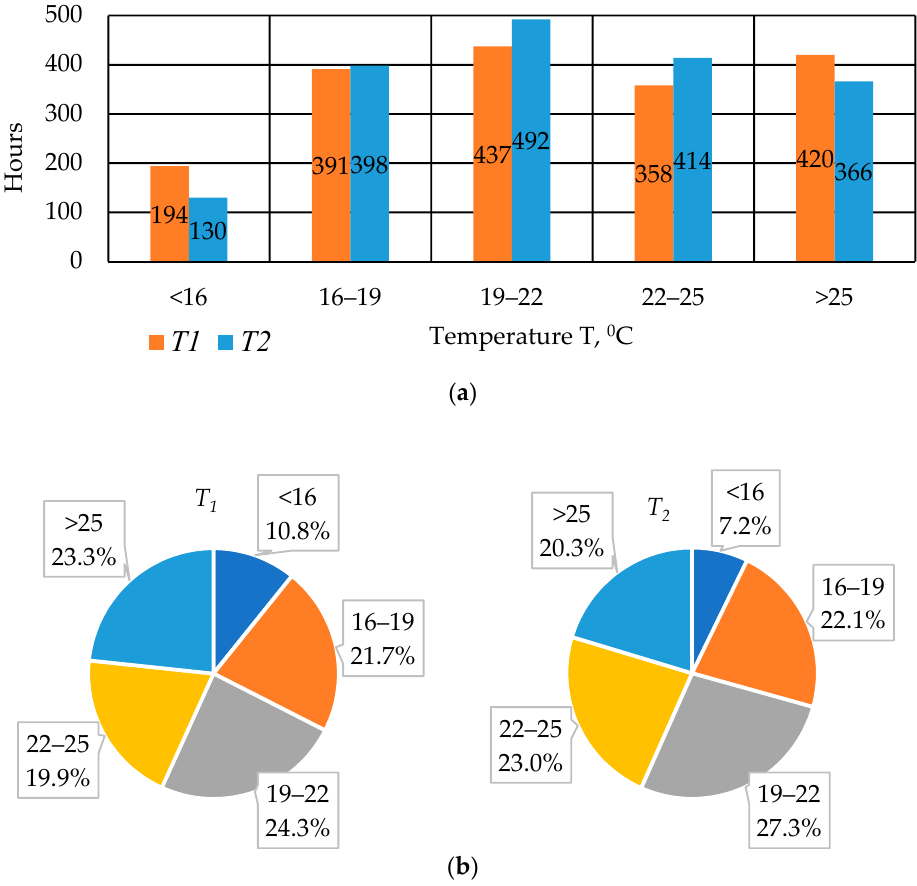
Figure 5. Temperature distribution by hours ( a ) and by percentage ( b )